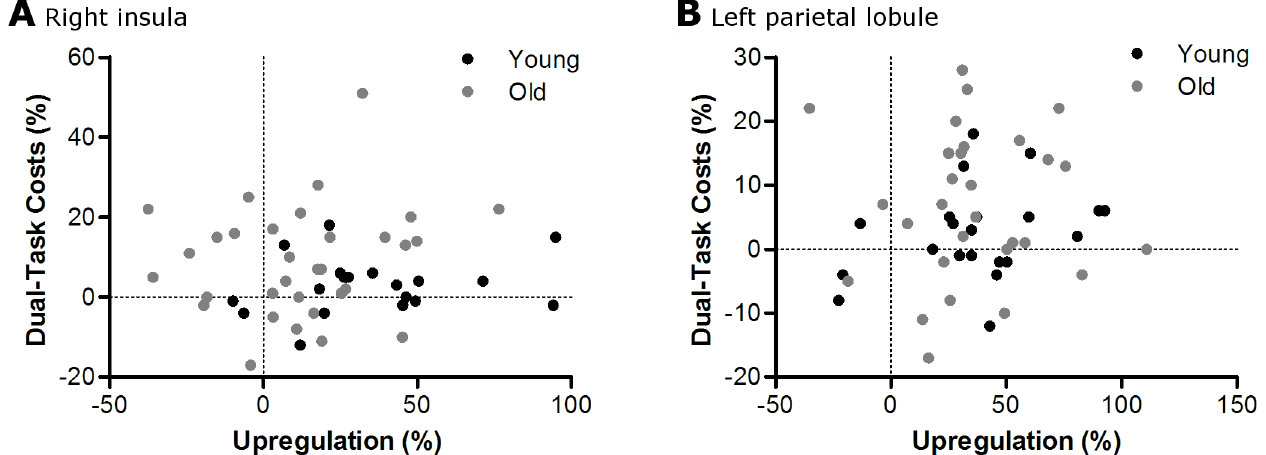
Fig 5. Scatter plots showing no relationship between the upregulation in BOLD response and the performance decline from single- to dual-tasking in the right insula (A) and the left parietal lobule (B).